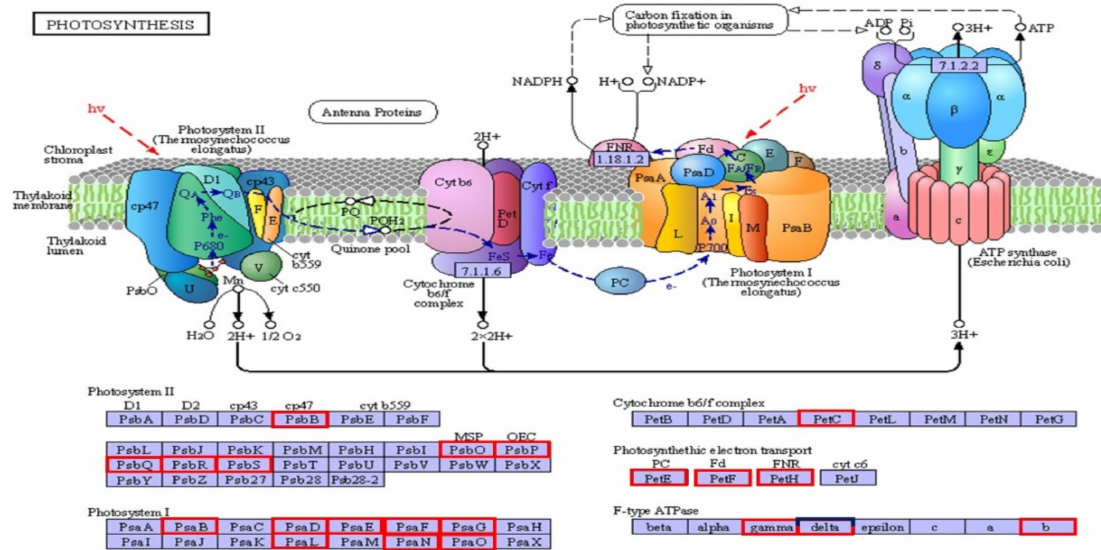
Figure 2. DEGs involved in photosynthesis pathway of blanched (post-blanching) stem of water dropwort. Red color boxes indicate the downregulated genes, and the blue color represents the upregulated gene